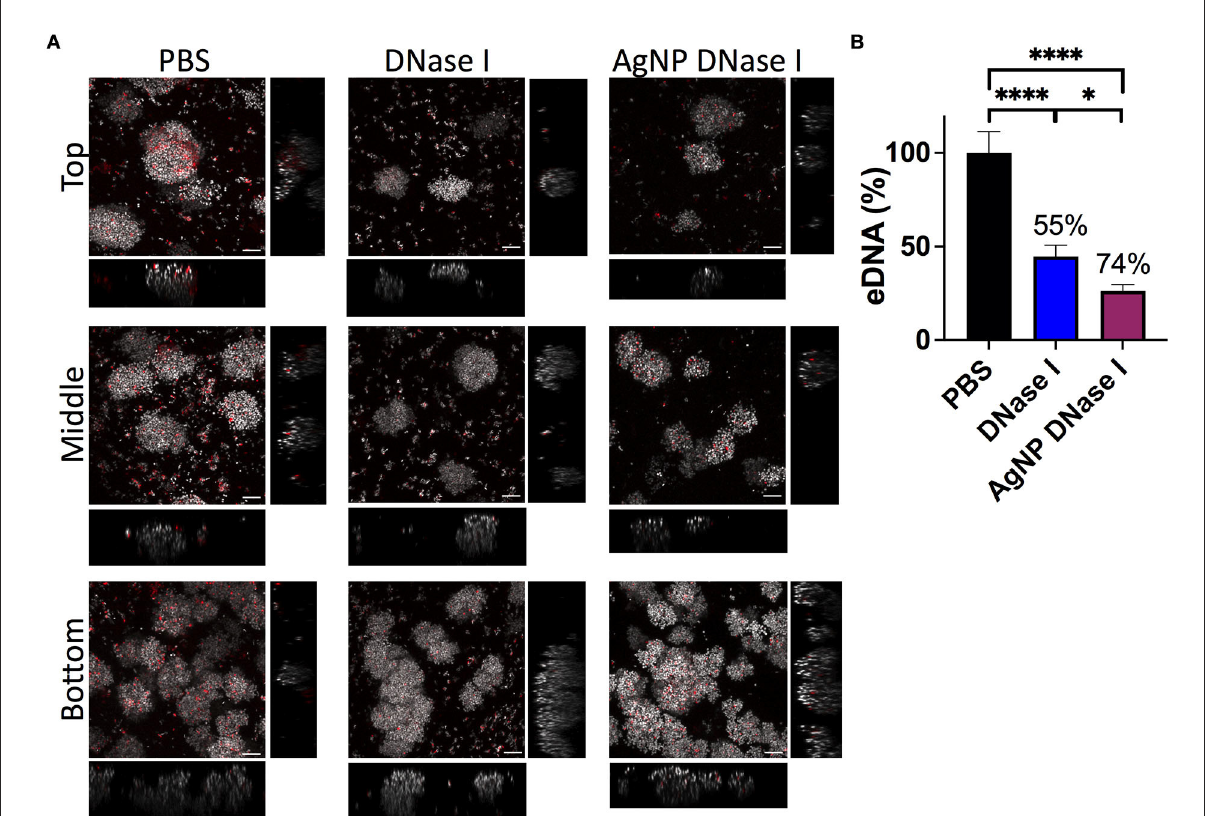
FIGURE7 eDNA in the WLB. eDNA analysis in an untreated clot (PBS) and treated with DNase I in a soluble form or encapsulated in a silver nanoparticle (AgNP). (A) Presence of eDNA in the top, middle, and bottom parts of the WLB. The dye SYTO60 (gray) stains the inner DNA of the bacteria; the dye TOTO-1 (red) stains the eDNA of the samples. Images were taken at a 63x magnification, and the scale bars represent 10 µ m. (B) Percentage of eDNA present in the untreated clot and the clot treated with DNase I. Numbers above each bar indicate the percentages of reduction of eDNA comparing treated to untreated samples. The statistical analysis was performed using the Student Unpaired t -test (* p < 0.05; **** p <